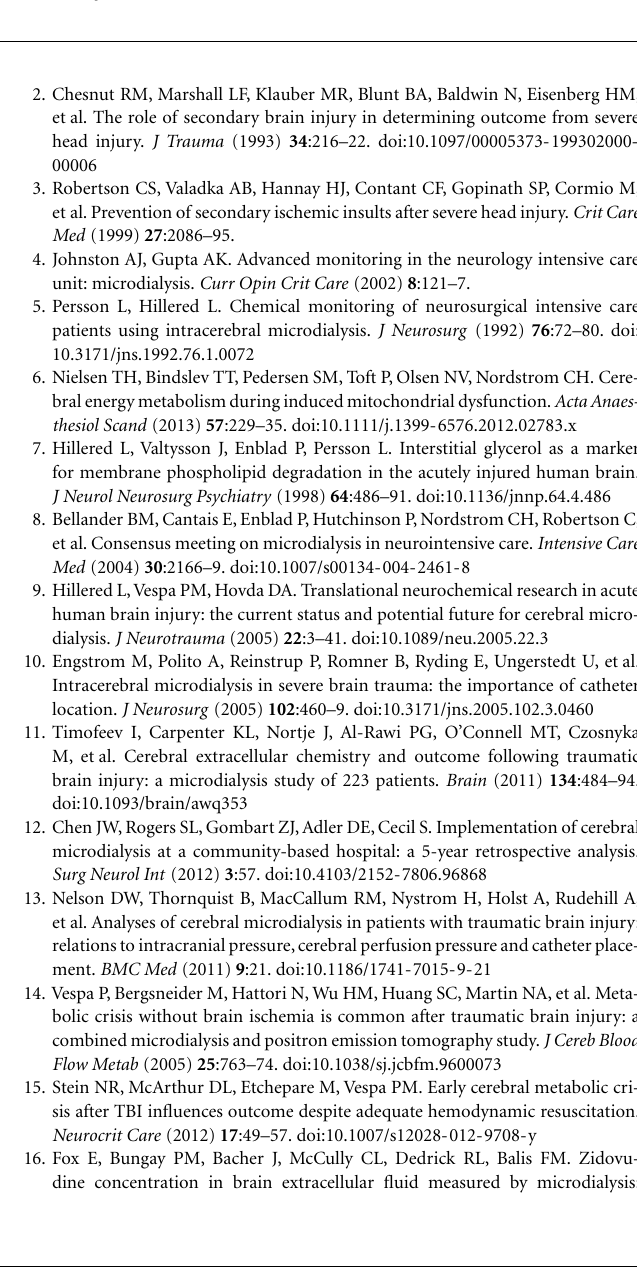
FIGURE 5 | Median ( ± 1st–3rd quartile) CSF-MD lactate (A) and pyruvate (B) levels in patients with favorable ( n = 6) (GOSe 6–8) and unfavorable (GOSe 1–5) outcome ( n = 8) . One bar represents two